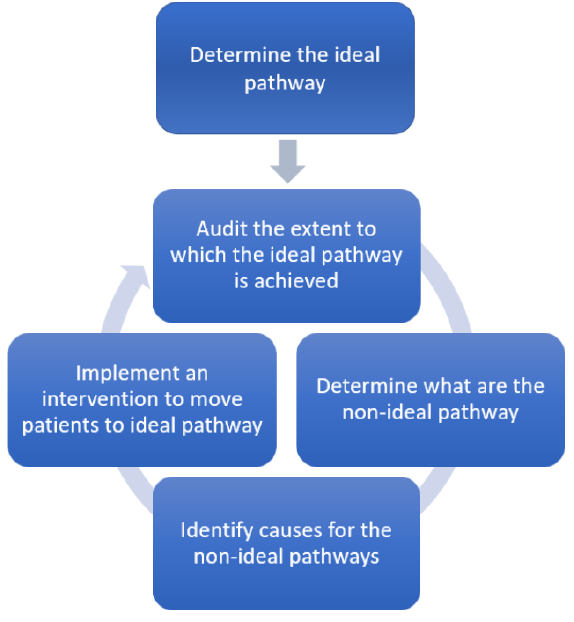
Figure 5. The care pathway audit